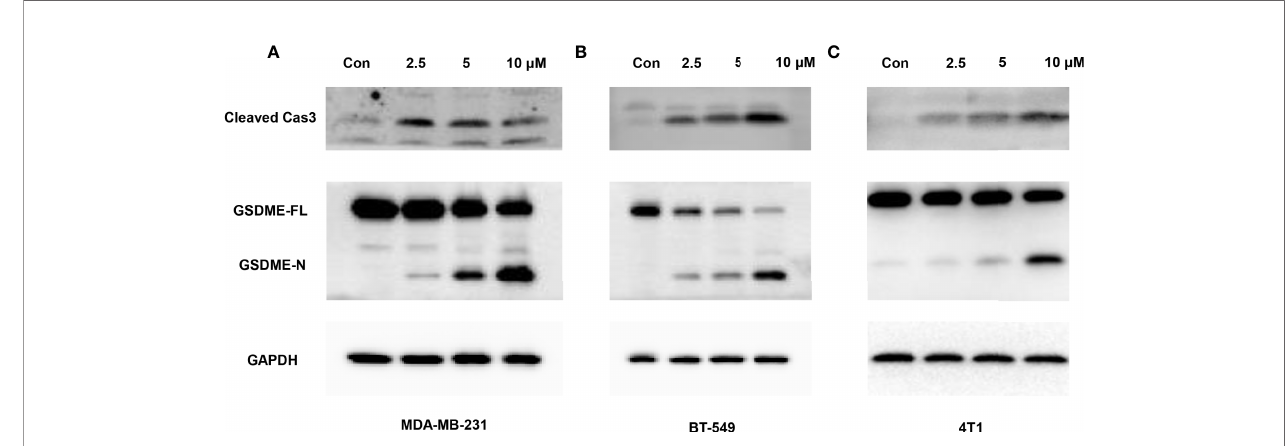
FIGURE 5 | Caspase-3-mediated cleavage of GSDME is involved in GW-8510-induced pyroptosis in TNBC cells. Representative immunoblot analysis of cleaved caspase-3 and N-terminal fragments of GSDME in (A, B) human TNBC cells (MDA-MB-231, BT549) cells and (C) mouse TNBC cells (4T1) treated with GW-8510 with 0, 2.5, 5, and 10 m M for 24 h. GAPDH was used as an internal